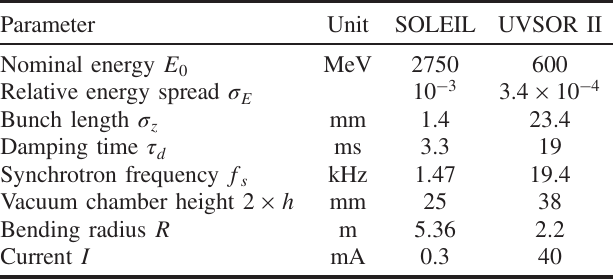
TABLE I. Parameters of SOLEIL and UVSOR II storage rings used in the numerical